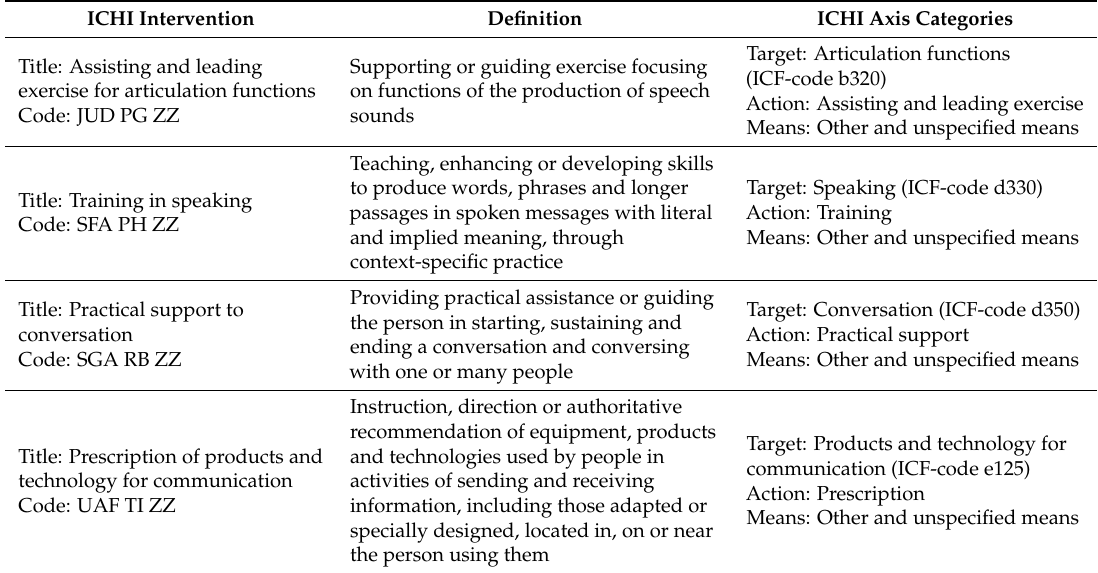
Table 1. Examples of ICHI interventions targeting body functions, activities and participation domains and environmental